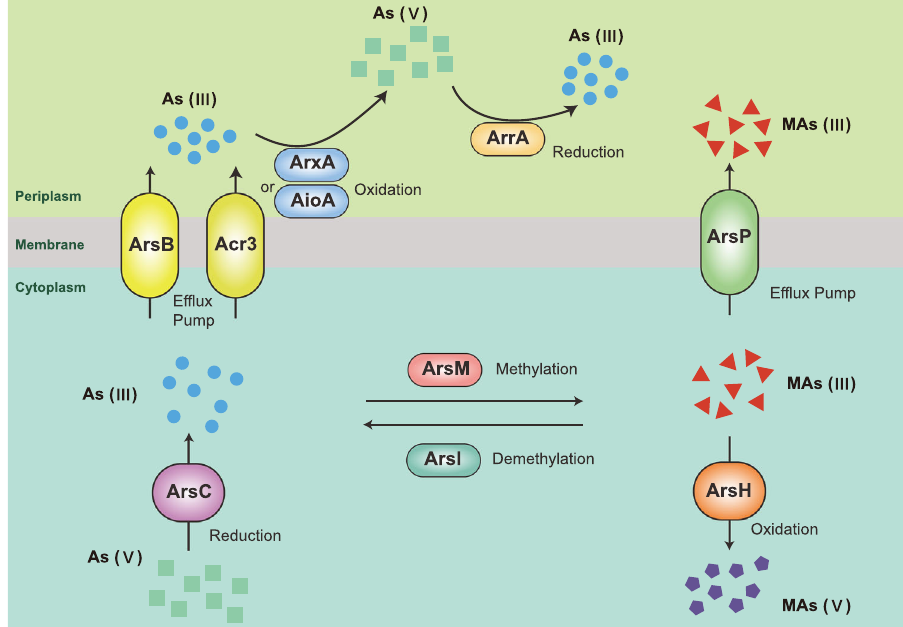
Fig. 1 Diagram of the microbial transformations of As. As(III), arsenite; As(V), arsenate; MAs(III), trivalent methylarsenite; MAs(V), pentavalent methylarsenate. As(III) ef fl ux permease: ArsB/Acr3; cytoplasmic As(V) reductase: ArsC; respiratory As(V) reductase: ArrA; As(III) oxidase: AioA/ ArxA; As(III) S-adenosylmethionine (SAM) methyltransferase: ArsM; C-As lyase: ArsI; MAs(III) ef fl ux permease: ArsP; MAs(III)-speci fi c oxidase: